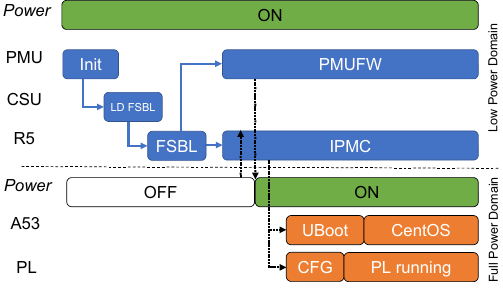
Figure 5: Boot sequence of the Zynq Ultrascale +